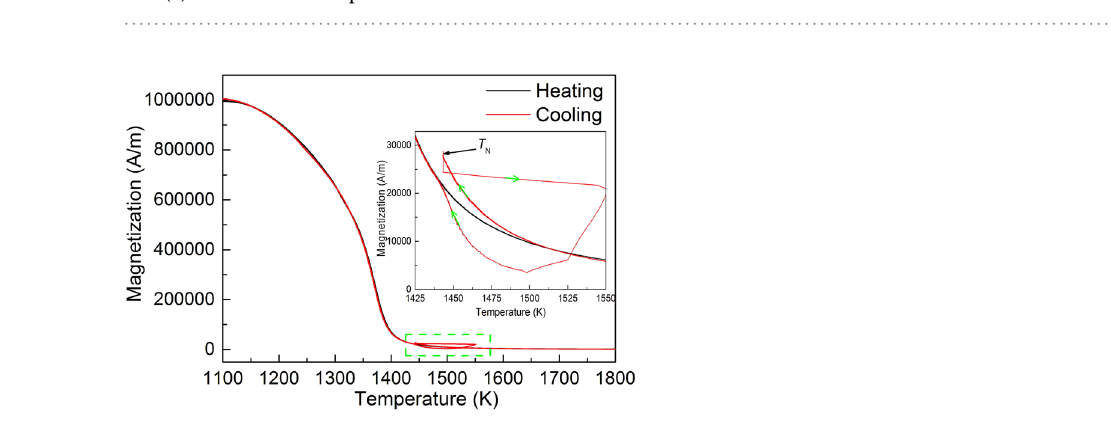
Figure 1. ( a ) Temperature profiles of Co during heating and cooling, and enlarged area showing the ( b ) melting and ( c ) solidification temperature.